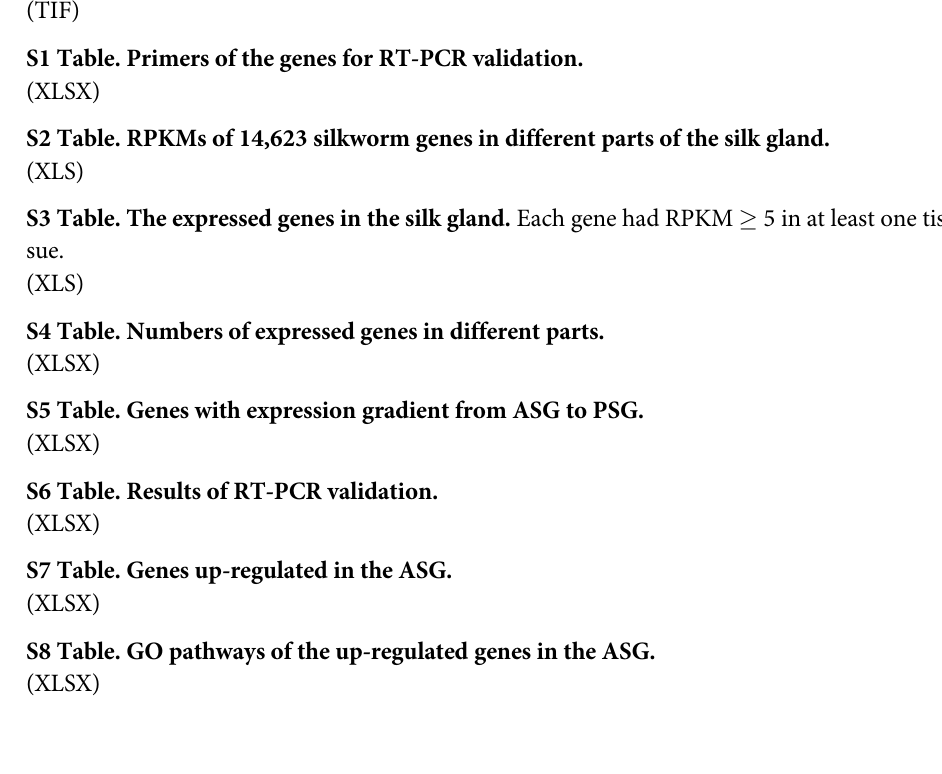
S1 Fig. Pathways involved in the domain biological process. Colors indicate the significance of the pathways. Arrows indicate the relationships through the pathways. S2 Fig. Pathways involved in the domain molecular function. Colors indicate the significance of the pathways. Arrows indicate the relationships through the pathways. S3 Fig. Pathways involved in the domain cellular component. Colors indicate the signifi- cance of the pathways. Arrows indicate the relationships through the pathways. S1 Table. Primers of the genes for RT-PCR validation.